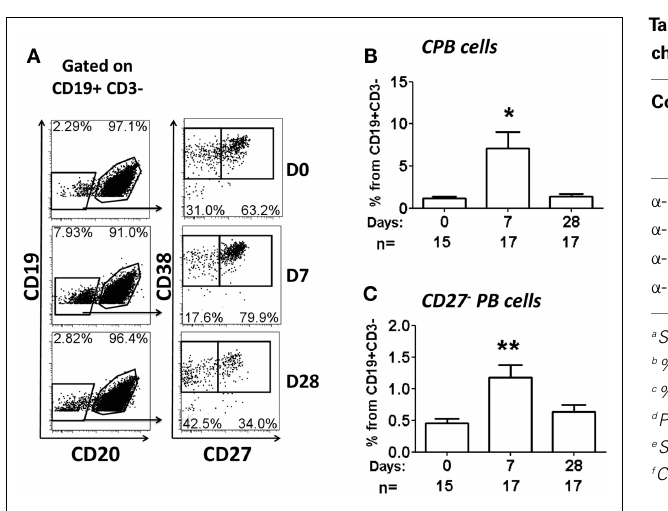
FIGURE 5 | Percentage of CPB and CD27 − PB cells following oral immunization . (A) Example of population gating (CPB and CD27 − PB cells) at different time points (days 0, 7, and 28) in a representative vaccinated volunteer. (B,C) Show a compilation of the percentage of CPB and CD27 − PB (as percentage of CD19 + CD3 − ), respectively, from all vaccinees. Bars indicate arithmetic mean ( ± SEM). Asterisks show statistical significance when compared to day 0 (* p < 0.05; ** p < 0.005).